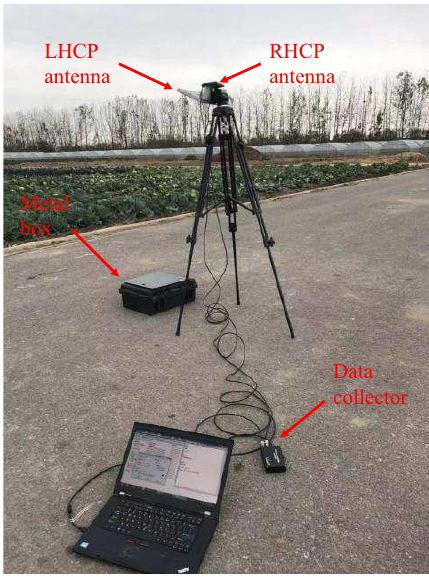
Figure 6. Measurement setup for ground target detection using BeiDou reflected signals. The metal box is placed in the footprint of the left-handed circularly polarized (LHCP) antenna in the